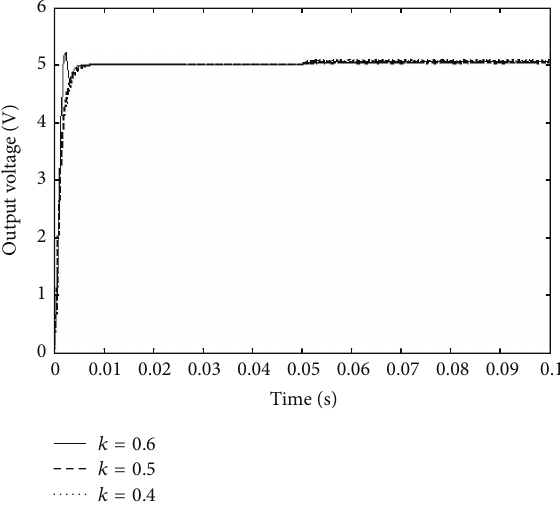
Figure 11: The DC/DC output voltage for step load variation with respect to different values of 𝑘 in indirect control method.